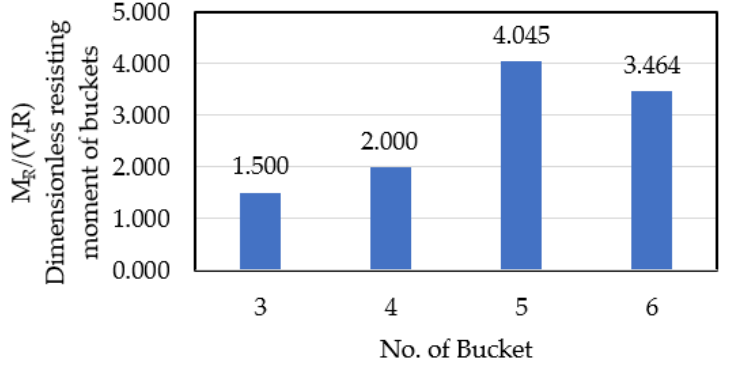
Figure 2. Top view of PSB [6].